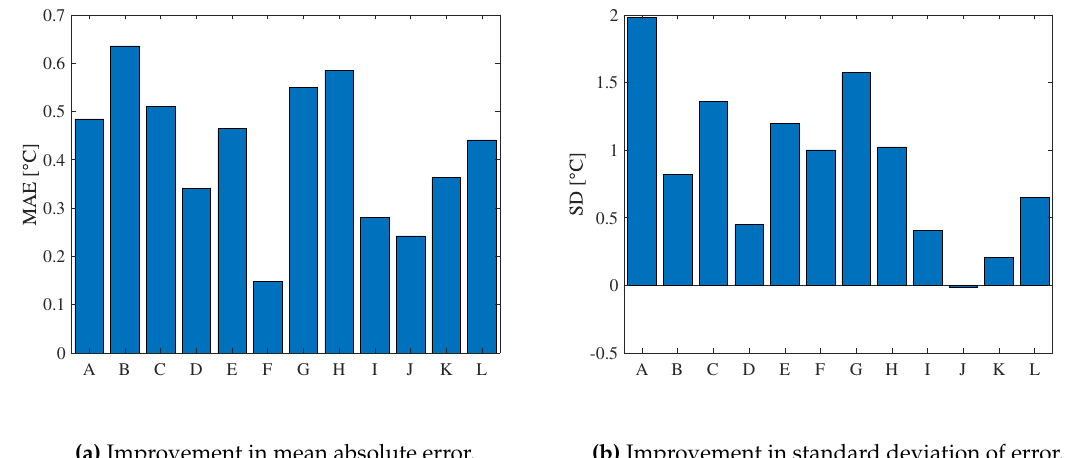
Figure 12. Improvement of ThermalWrist from baseline.